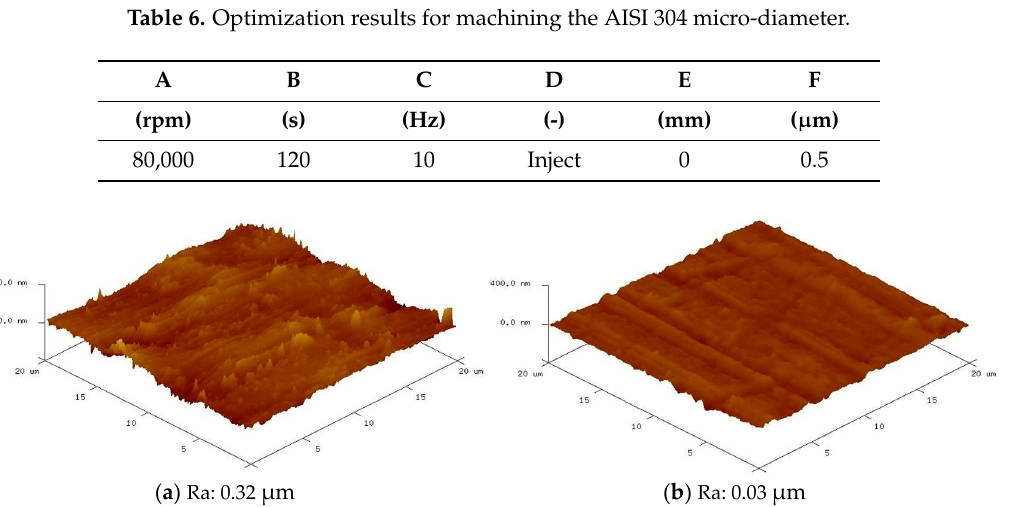
Table 7. Analysis of variance for the machining micro-diameter.